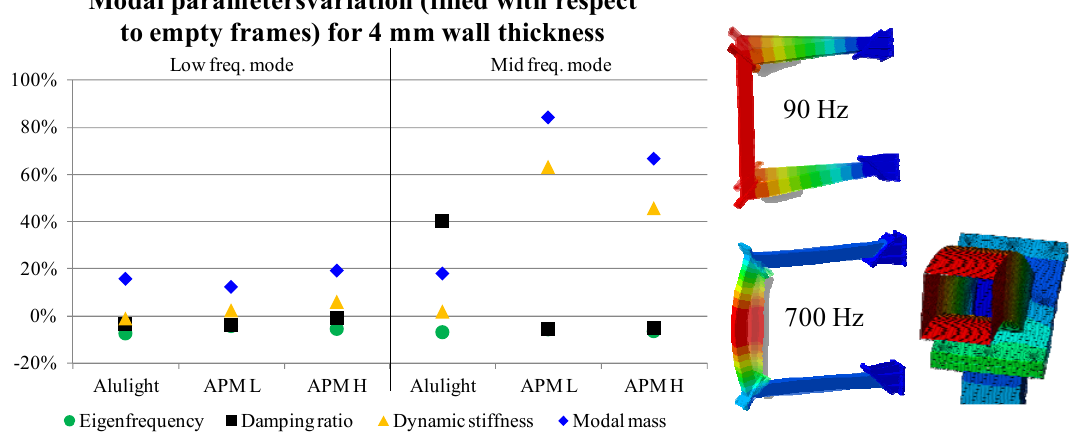
Figure 5. Modal parameters for the 4 mm tube wall thickness (low and mid frequency modes) and corresponding mode shapes. False colors represent normalized displacements.